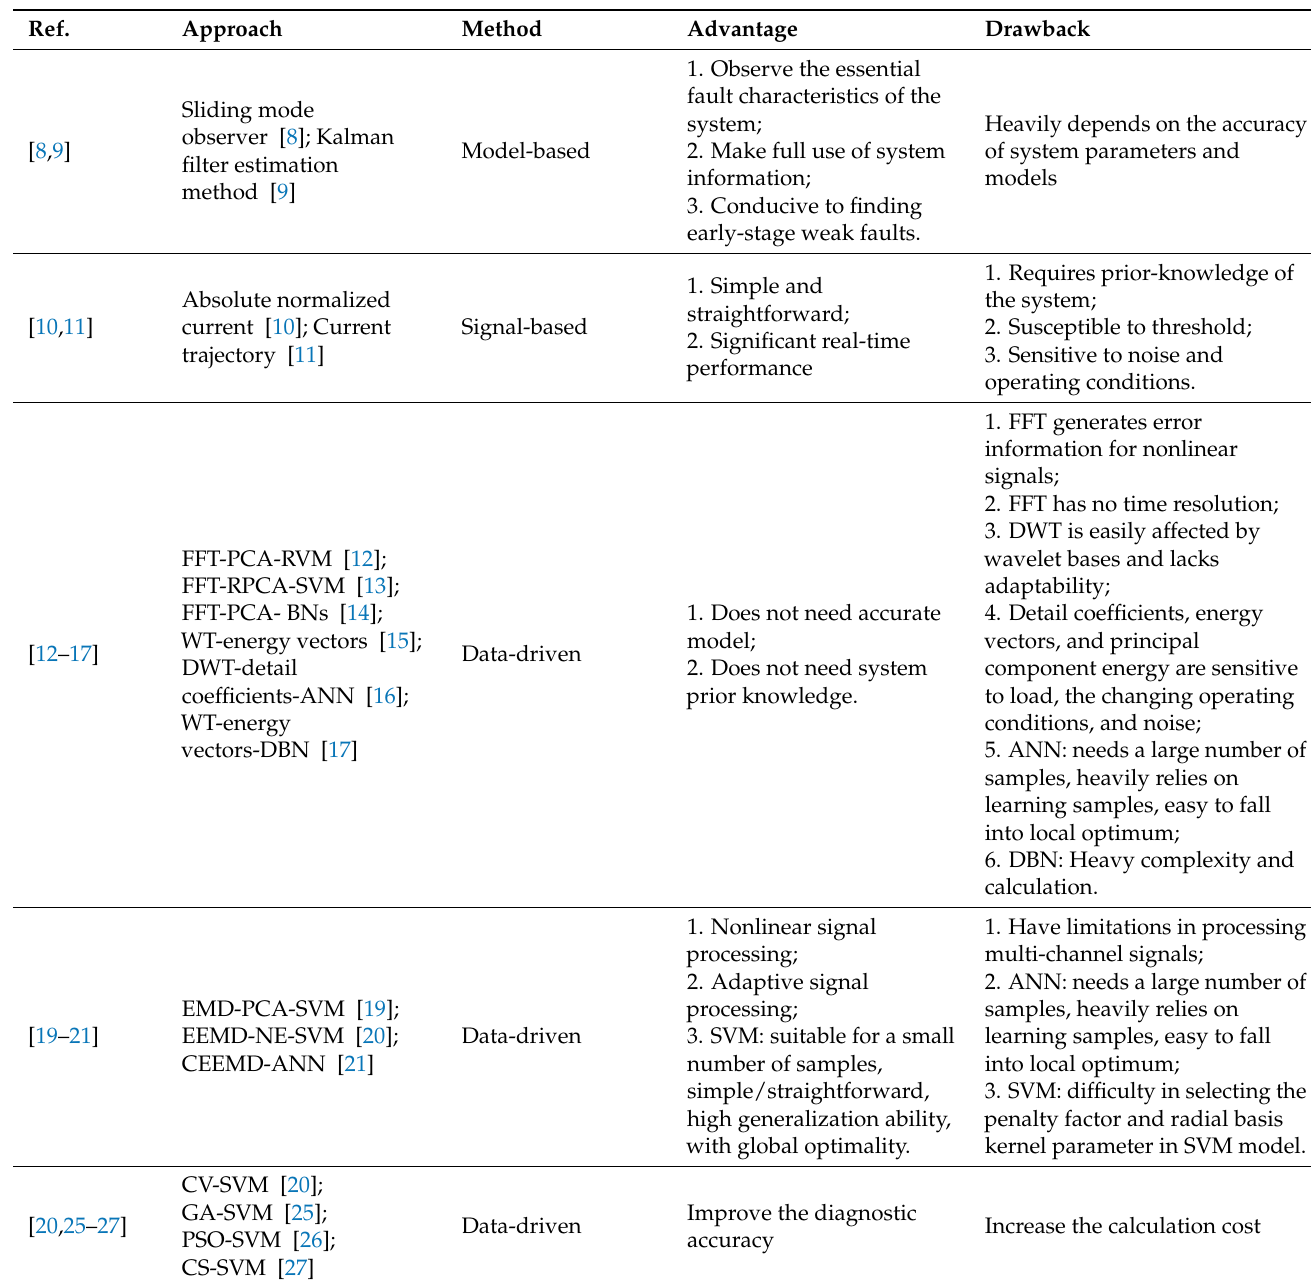
Table 1. Comparison of converter fault diagnosis